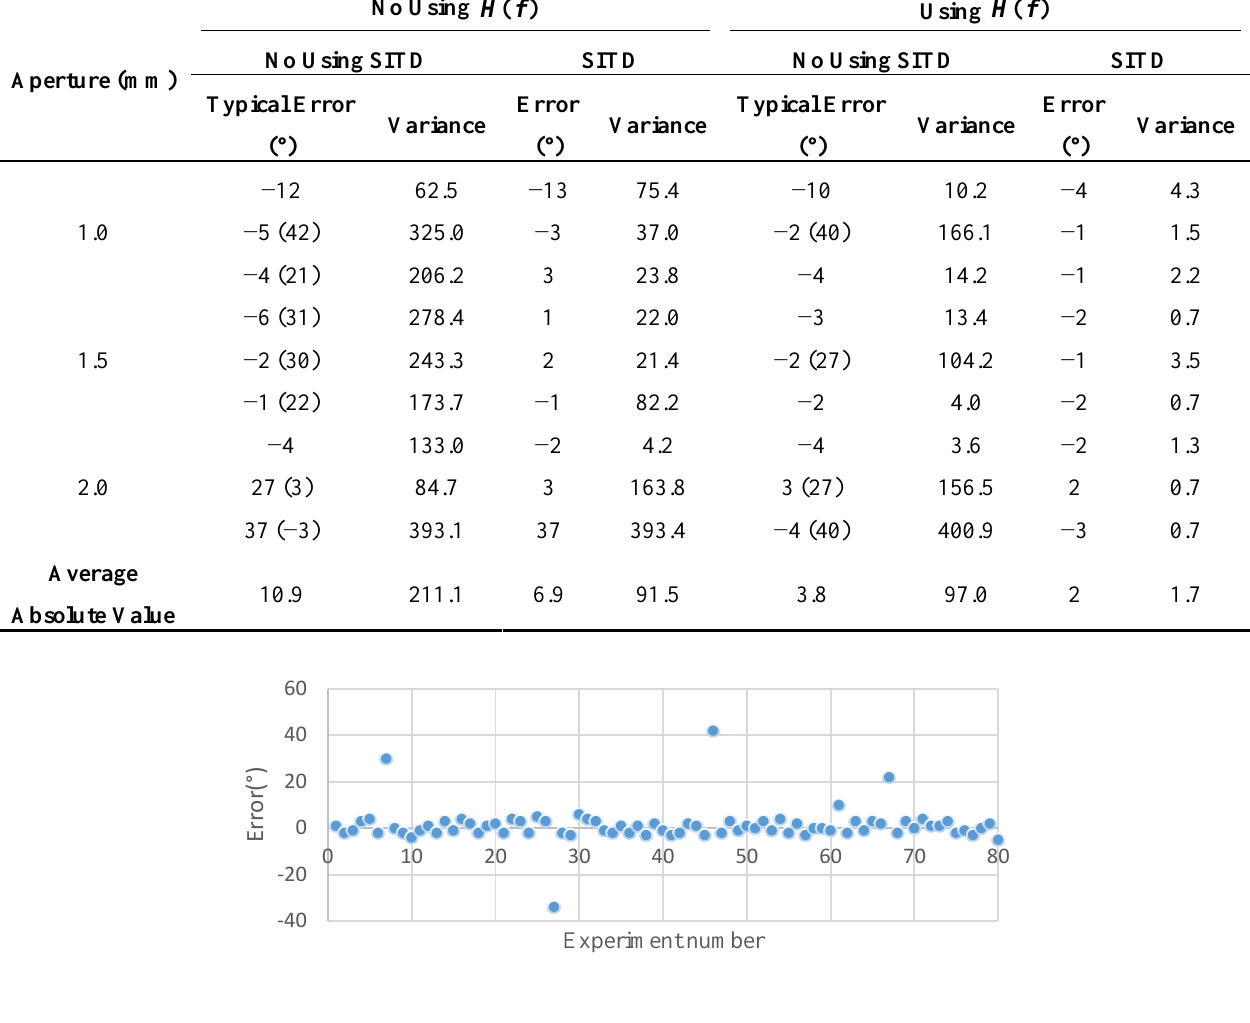
Figure 16. Orientation error.